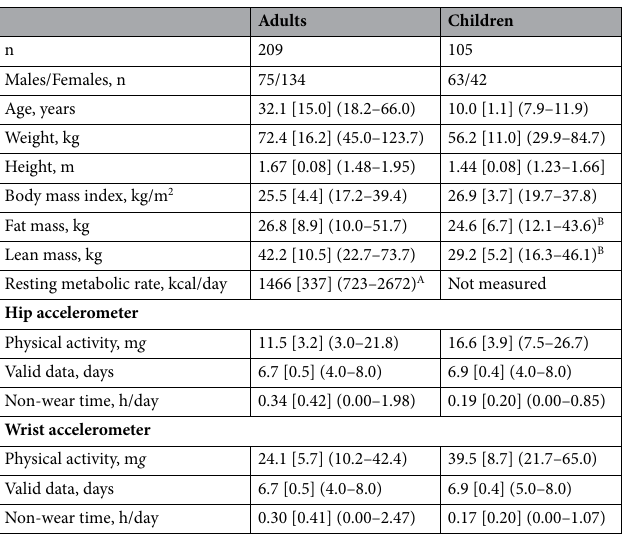
Table 1. Characteristics of the subjects. Data are mean [standard deviation] (minimum − maximum). A n = 169; B n =